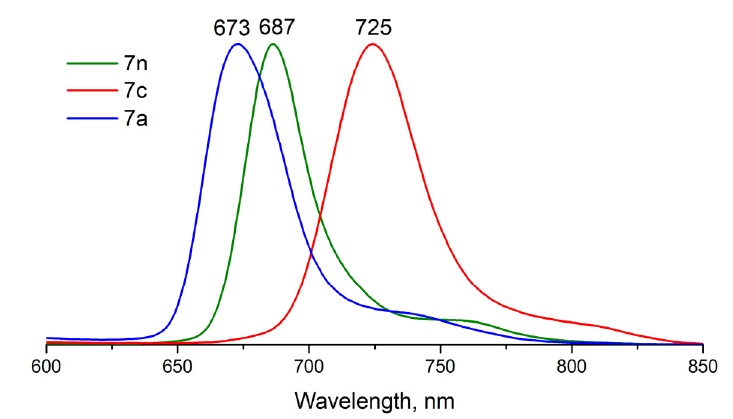
Figure 6. Normalized emission spectra of different forms of compound 7 in DMSO.